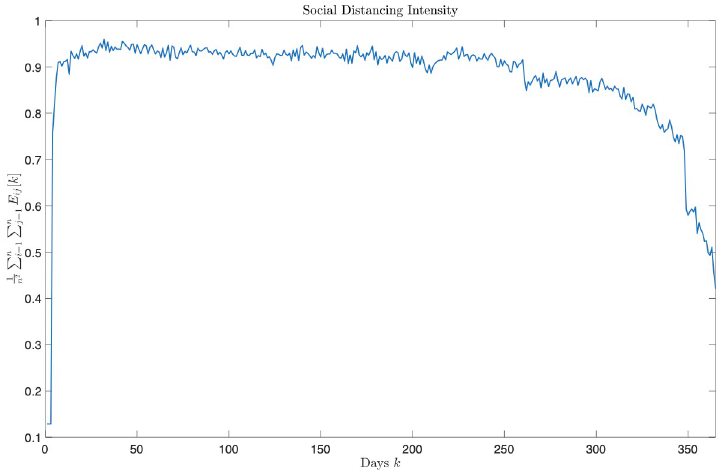
Fig 3. Intervention plan corresponding to the found solution in terms of the intensity of social distancing measures plotted against time.